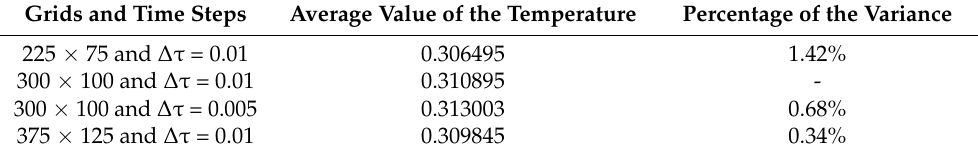
Figure 2. Temperature time series at P 2 (0, 0.4) for Ra = 10 8 with distinct grids and timesteps.